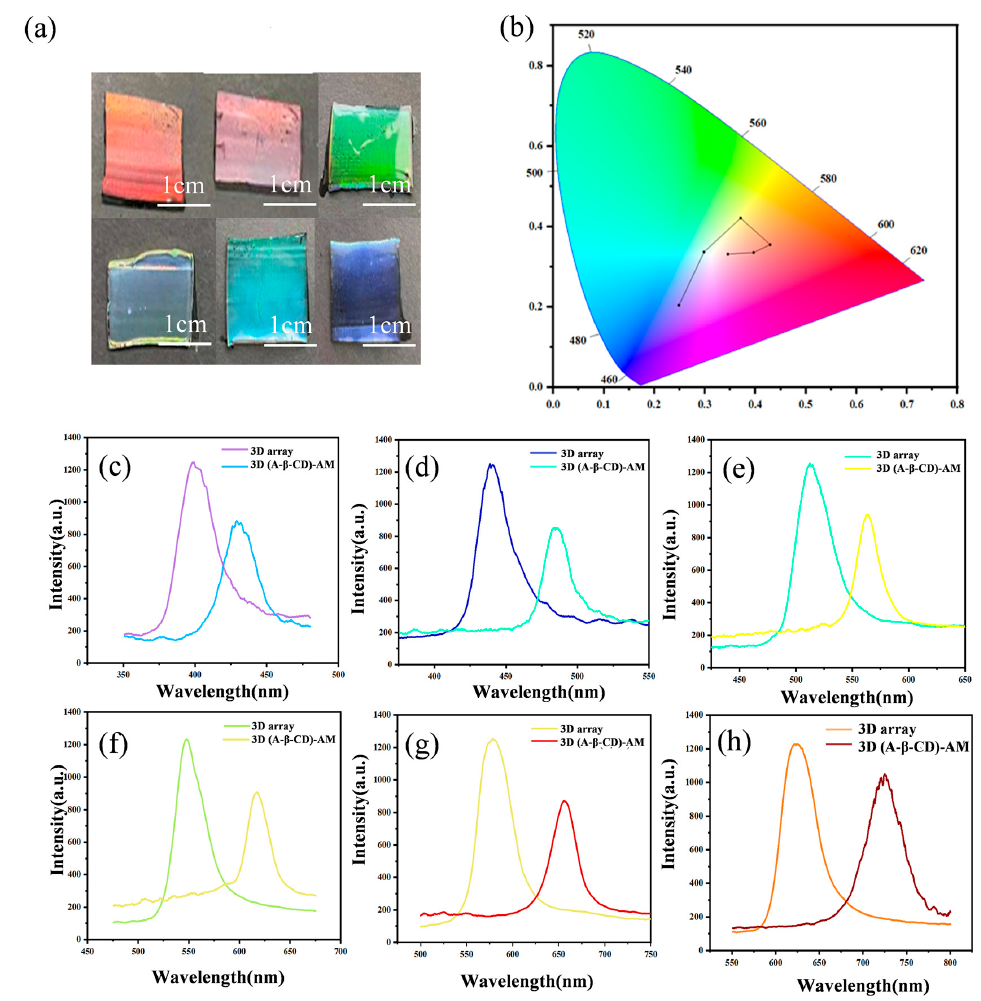
Figure 3. ( a ) Optical photos of 3D O-(A- β -CD)-AM PCs of PMMA with different diameters; ( b ) CIE of 3D O-(A- β -CD)-AM PCs of PMMA with different diameters; ( c – h ) the reflection peak of 3D O-(A- β -CD)-AM PCs and PMMA arrays.